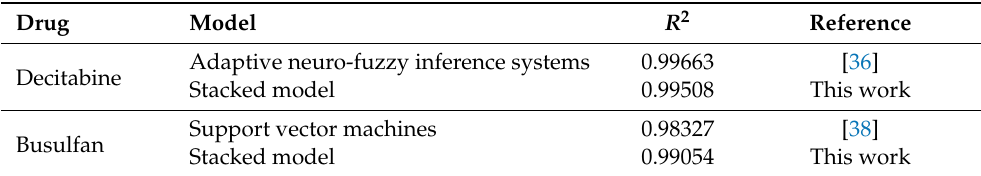
Table 5. Prediction accuracy of the stacked